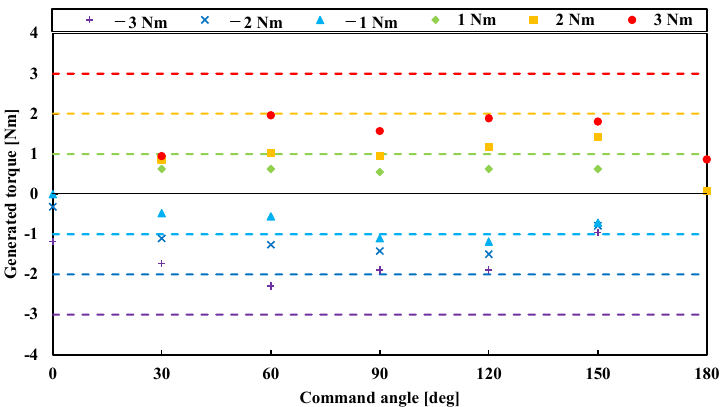
Figure 9. Measurement results of generated torque. In this graph, the vertical axis represents the generated torque, and the horizontal axis represents the command angle.